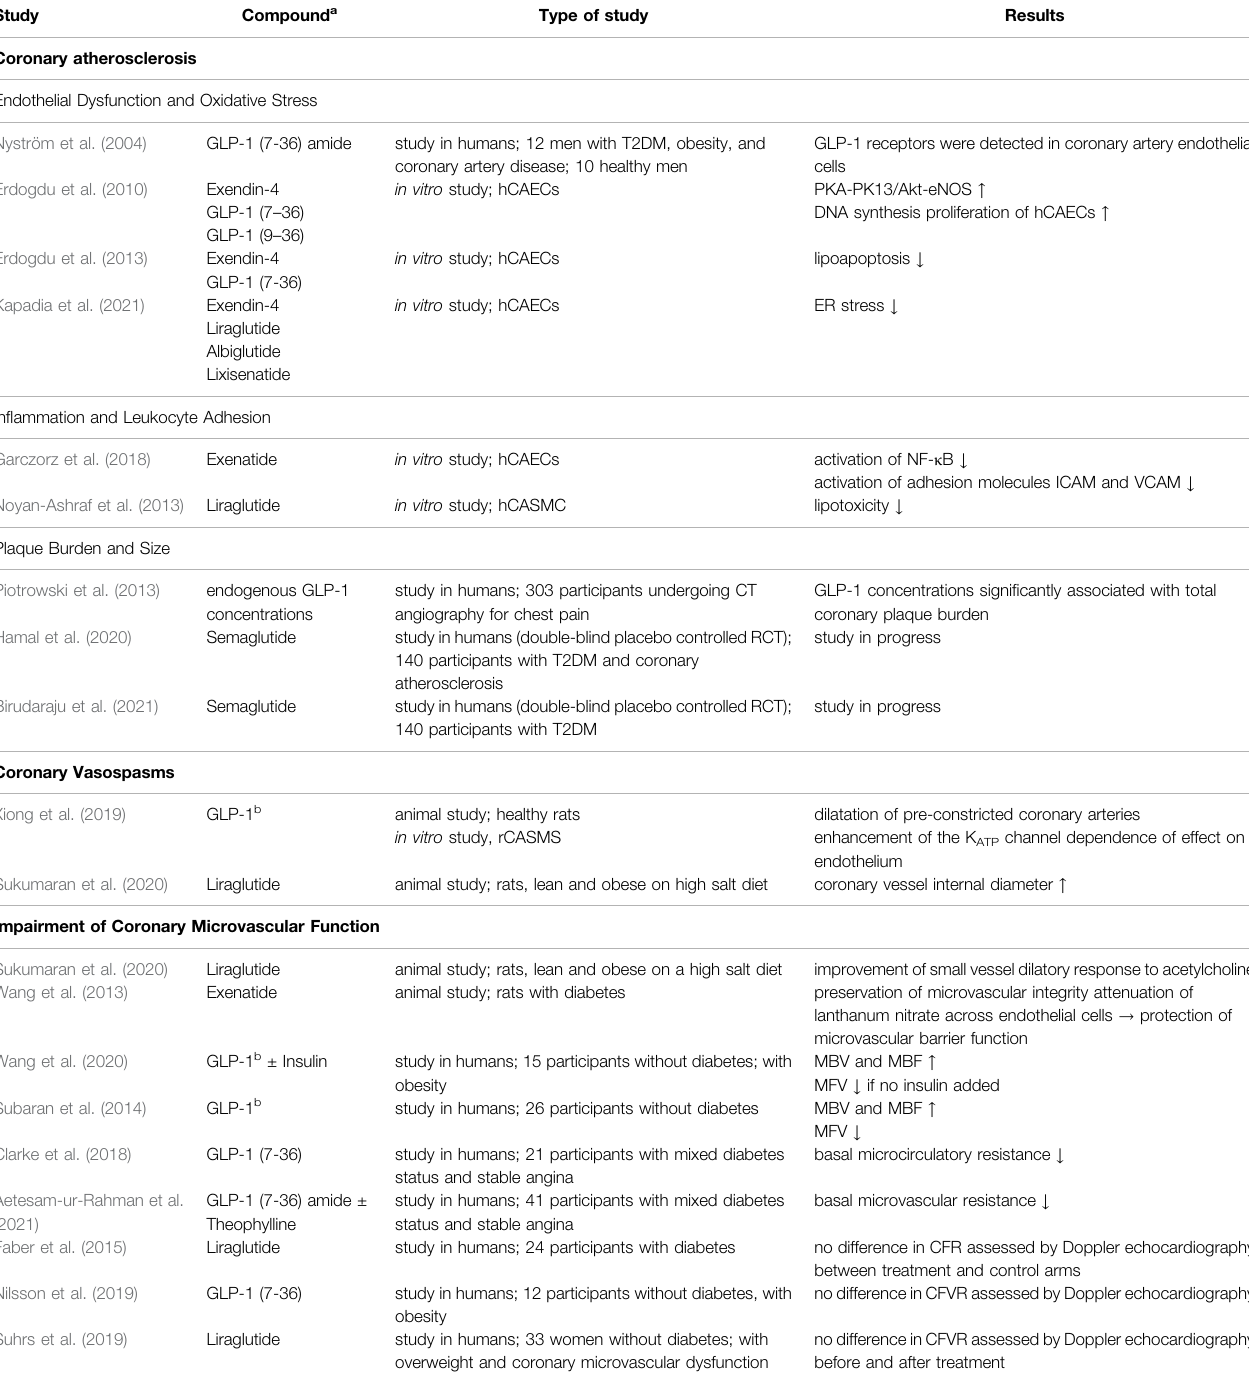
TABLE 1 | Effect of GLP-1 RAs on mechanisms leading to coronary